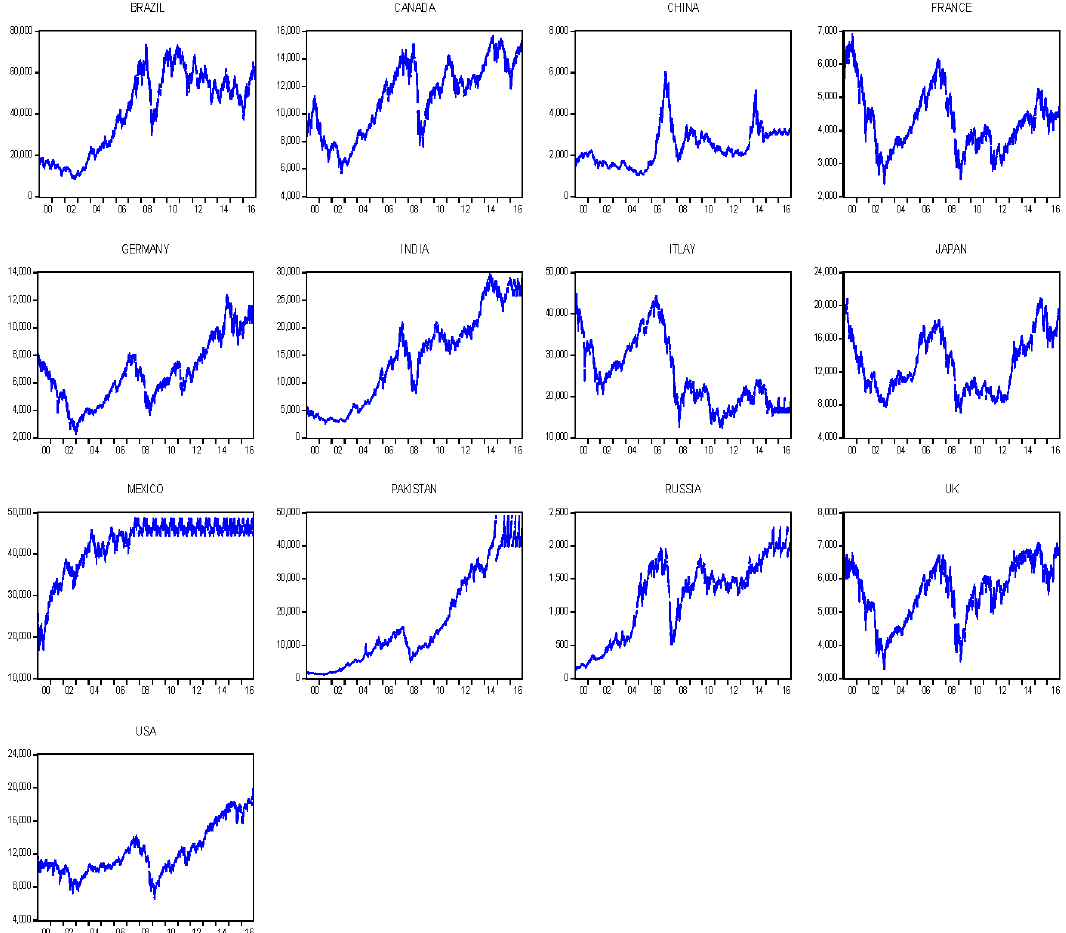
Figure A1. Graph of stock indices of sample countries.